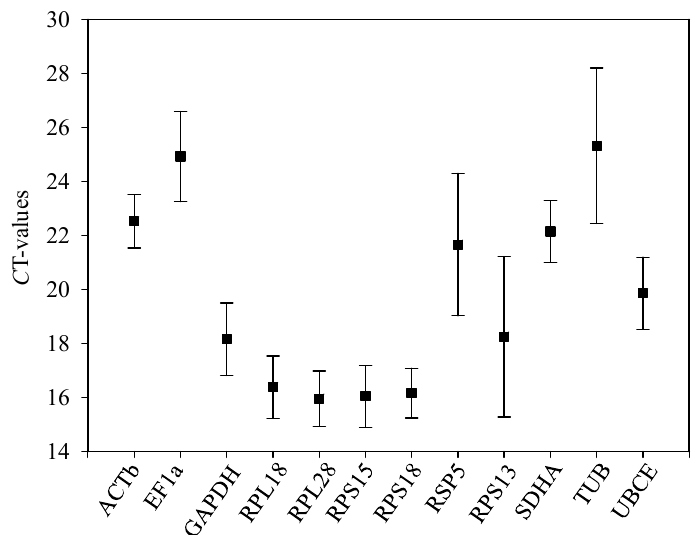
Figure 2. Expression profiles of the 12 housekeeping genes in all specimens of B. odoriphaga as indicated by cycle threshold ( C t ) values. Samples were from the assays with developmental stages, temperatures, populations, pesticides, diets, and photoperiods. Values are means ± SD.